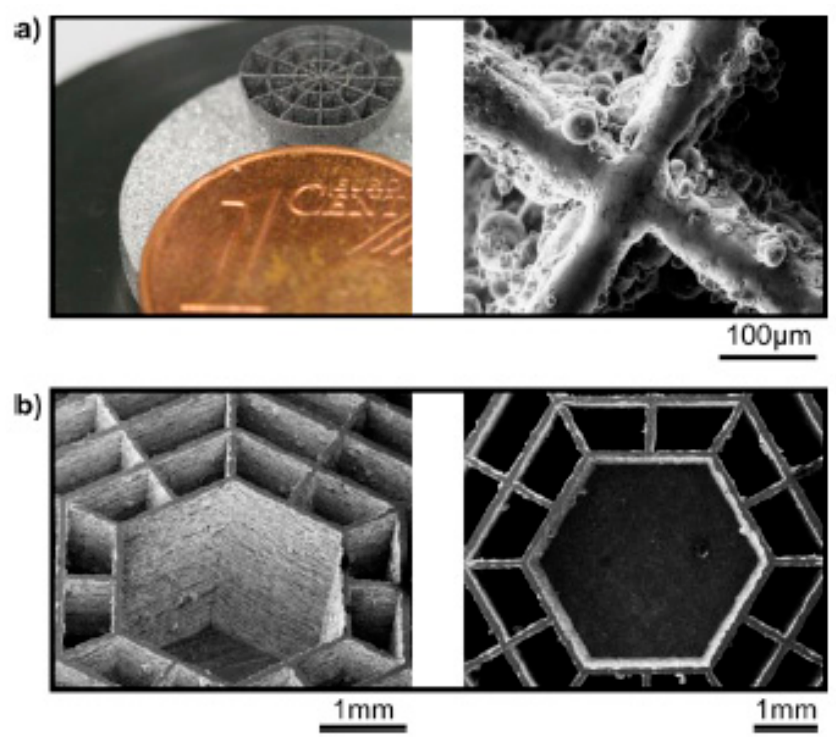
Figure 27. ( a ) Hollow thin-walled structure fabricated using fs-based AM; ( b ) hexagonal structure fabricated to a height of 5 mm (Adapted from reference [38]).